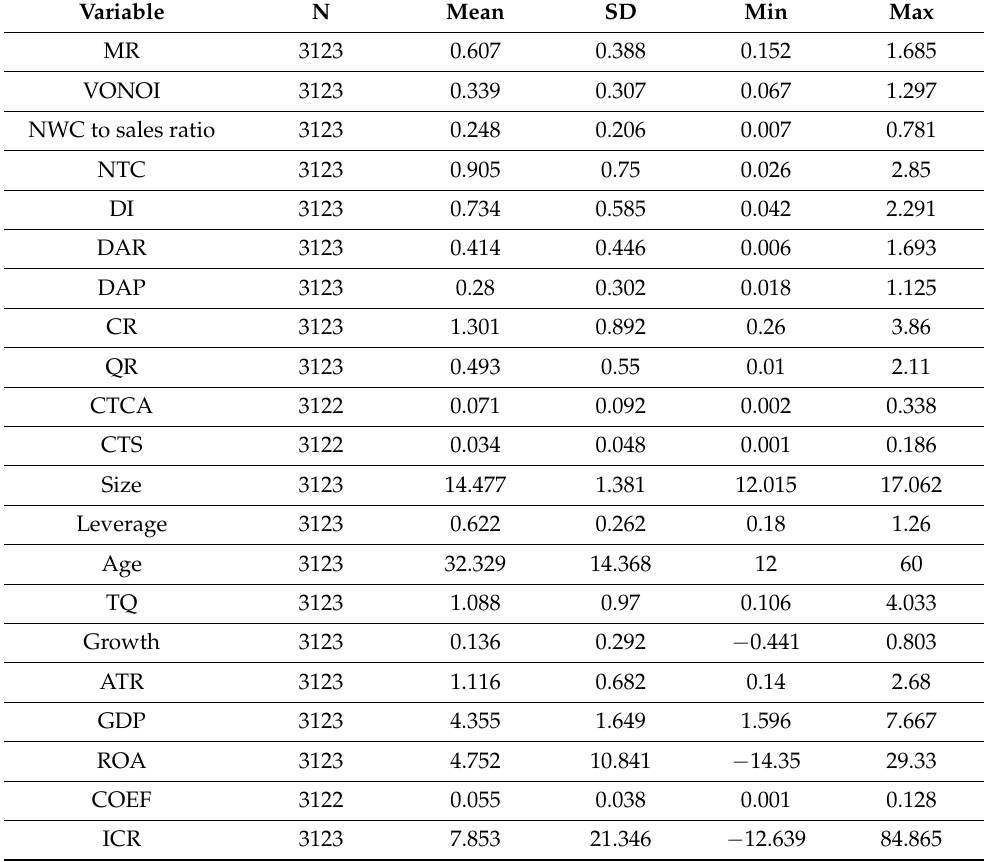
Table 3. Descriptive